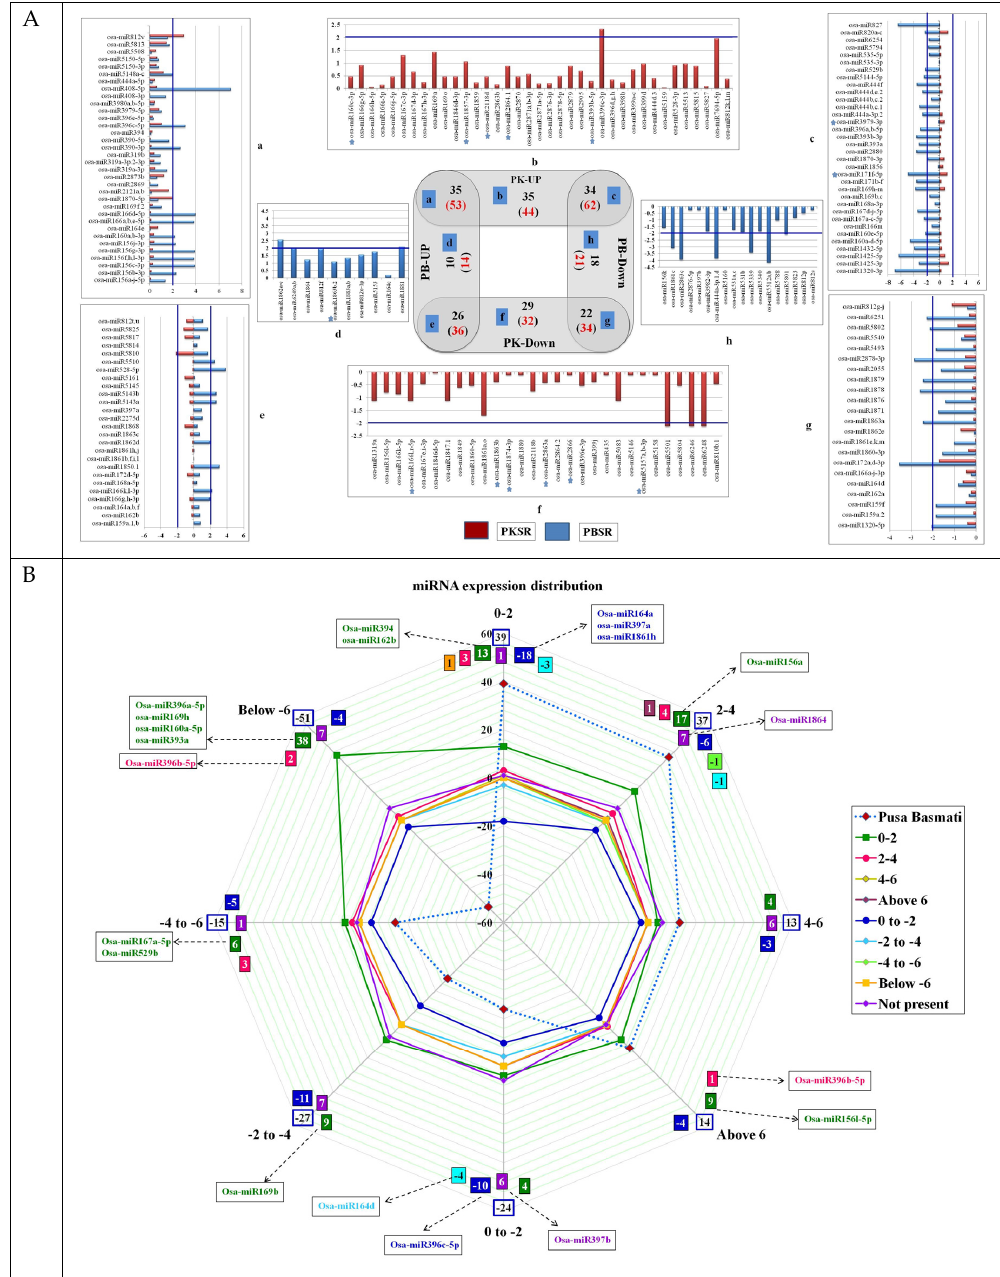
Figure 2. Expression profiles of osa-miRs. ( A ) Venn diagram representing the distribution and expression profiles of miRs across the four root libraries under control and experimental conditions. Graphs corresponding to panels a, c, e, and g represent the fold changes in miR expression in the presence of salt. Graphs corresponding to panels b, d, f, and h represent the digital expression of miRs. The samples include root tissues from Pokkali (PK) and Pusa Basmati (PB) grown in the presence (SR) and absence of salt (NR). ( B ) Graphical representation of fold change in miR expression levels in PB (dotted lines) and the relative changes observed in PK roots. A color code is used to indicate the fold range and number of miRs showing deregulation within that range.